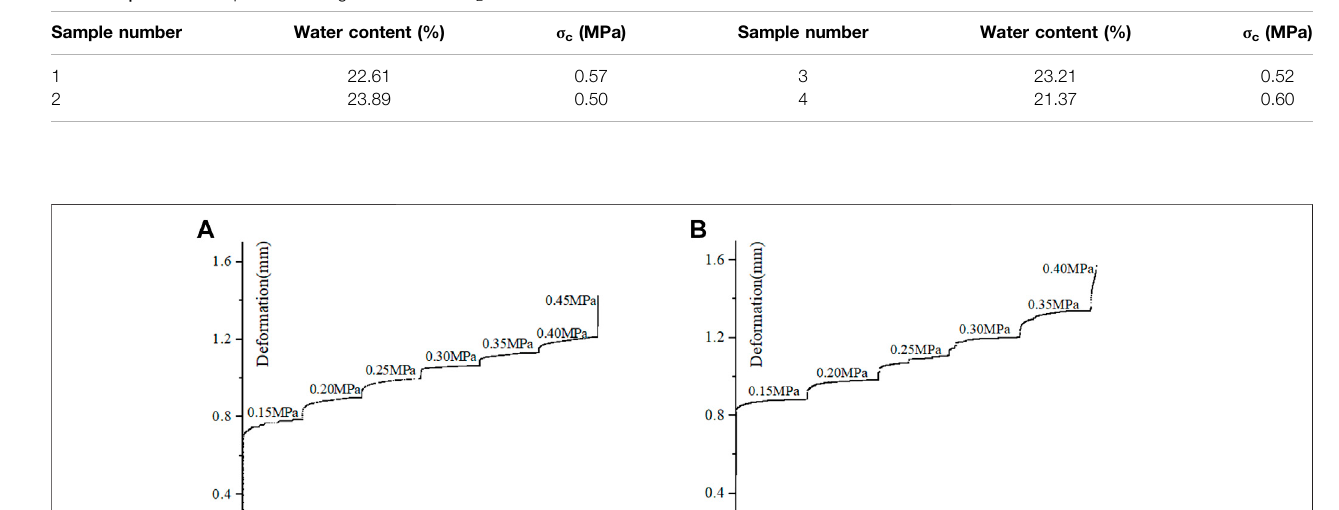
TABLE 2 | Uniaxial compressive strength of saturated Q 2 loess.